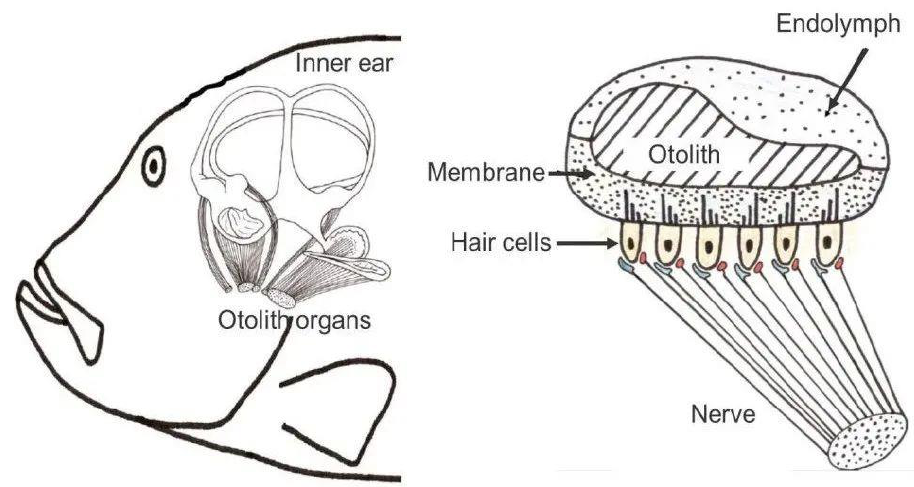
Figure 1. Otolith structure of a fish. Image Credits: Lasse Amundsen. The inner ear of fish is composed of the associated sensory region, three semicircular canals, and three otoliths (Saccule, Utricle, and Lagena); each of the three pockets has one otolith (Figure 2). The otoliths have Maculae, which are covered with sensory hair cells. Auditory hair cells convert sound signals into electrical signals which are recognized by the nervous system, and otoliths identify the direction of sound vibrations.